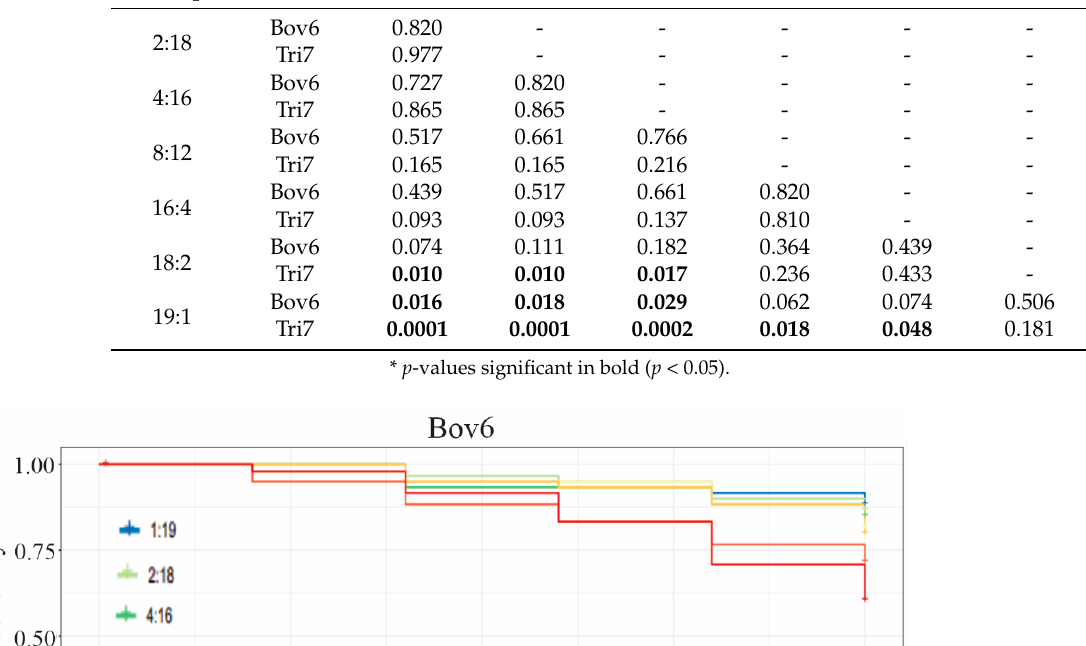
Table 3. p value of the survival analysis for groups of Atta sexdens rubropilosa Forel 1908 (Hymenoptera: Formicidae) workers contaminated with Beauveria bassiana (Bov6) and Trichoderma harzianum (Tri7).